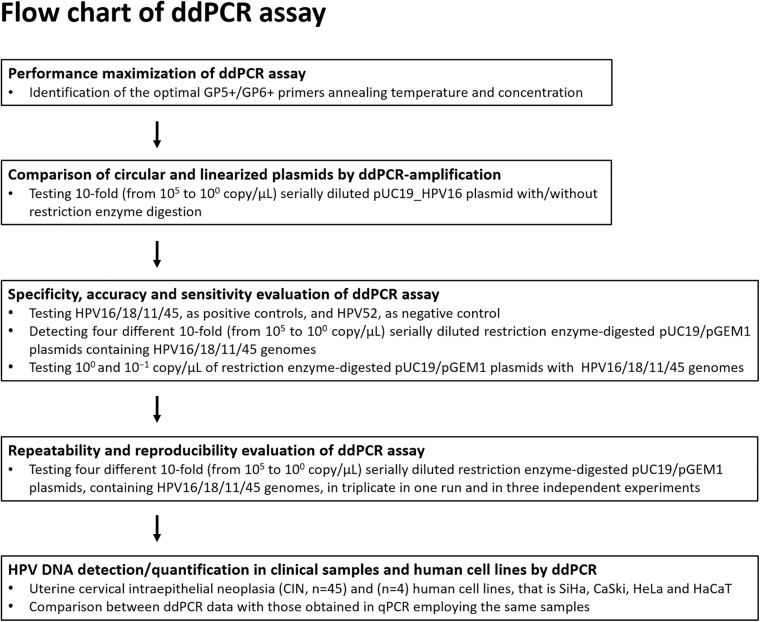
Flow diagram. The ddPCR set up and development for the detection and quantification of HPV16/18/11/45 DNAs from clinical specimens is represented in this diagram.